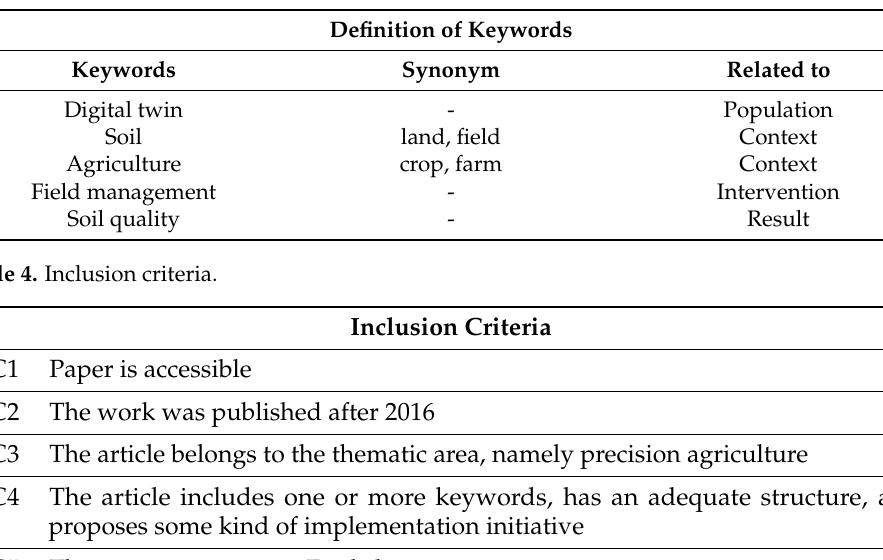
Table 3. Selection of keywords and